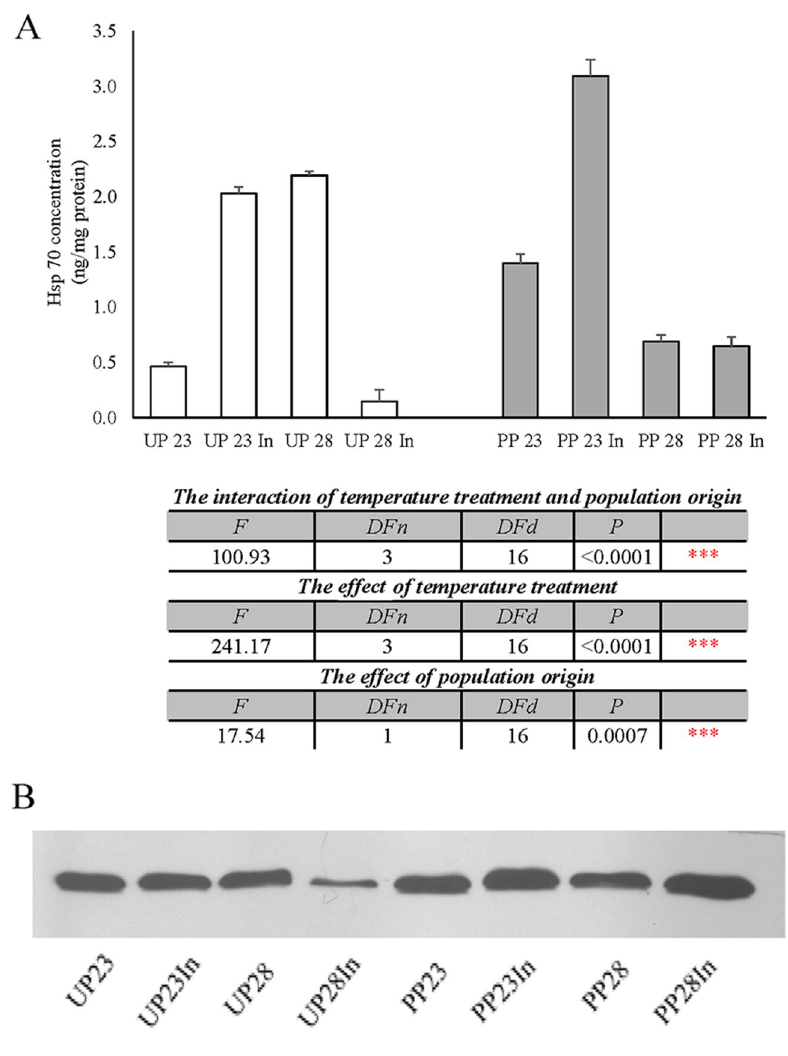
Figure 5. The total brain tissue hsp70 concentration quantified by indirect ELISA in 5th instar Lymantria dispar larvae exposed to different temperature treatments from unpolluted (UP groups) and polluted forest (PP groups) ( A ). Data expressed as mean ± standard error, ng/mg of proteins for (n = 15 larvae in each experimental group); All abbreviations are the same as in Fig. 1. Significance of the effects of the thermal treatments, population origin, and their interaction on the variance of larval brain hsp70 concentration, with thermal treatments as fixed factor (two-way ANOVA, p ≤ 0.05). Western blot of heat shock protein 70 (hsp70) from brain tissue ( B ). Western blot film is cropped, and original film is presented in Supplementary information, Fig. 4.